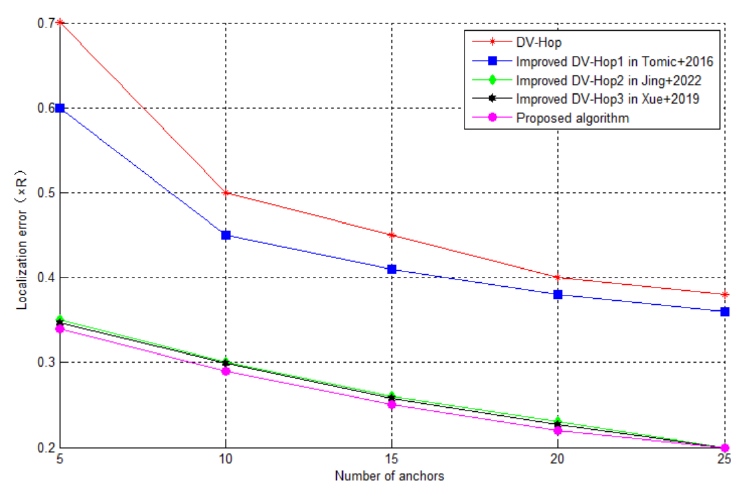
Figure 7. Comparison of localization errors of different BNs[21][22][23].